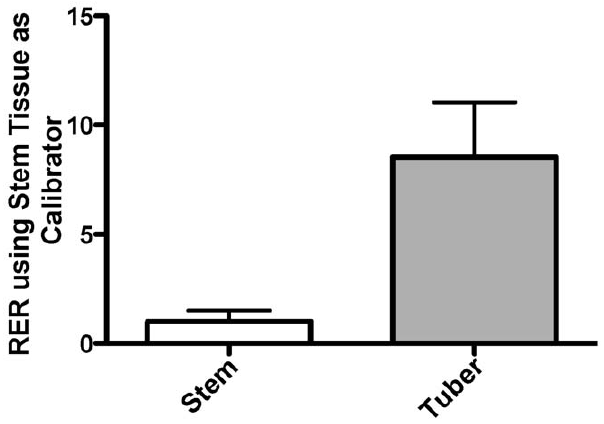
Figure 1. P.c. sp. carotovorumbudB transcript is differentially expressed in potato tubers and stems. Relative expression of the budB transcript in potato stems and tubers was determined with four reference mRNA ( ffh , dspE , pelB , and hrcC - Table 2). The mean relative expression ratio (RER) of the budB transcript in tubers was 8.5-fold elevated compared to stem tissue, which was used as the calibrator. The difference was found to be significant at a 95% confidence interval by t -test using Prism software (Mac version 5.0d, GraphPad Software, Inc.) with a P -value=0.0425. Error bars represent standard error of the